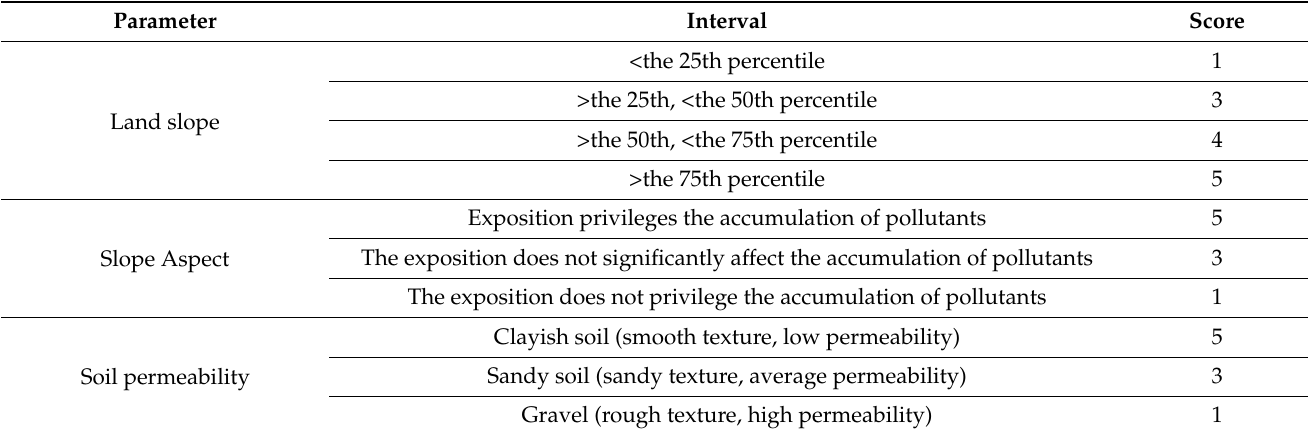
Table 5. Weights of indicators used in the calculation of Hazard